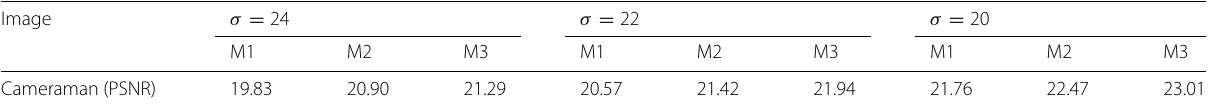
Table 4 Comparison of PSNR value of the restored image “Cameraman” for different additive noise values for three algorithms M1, M2, and M3